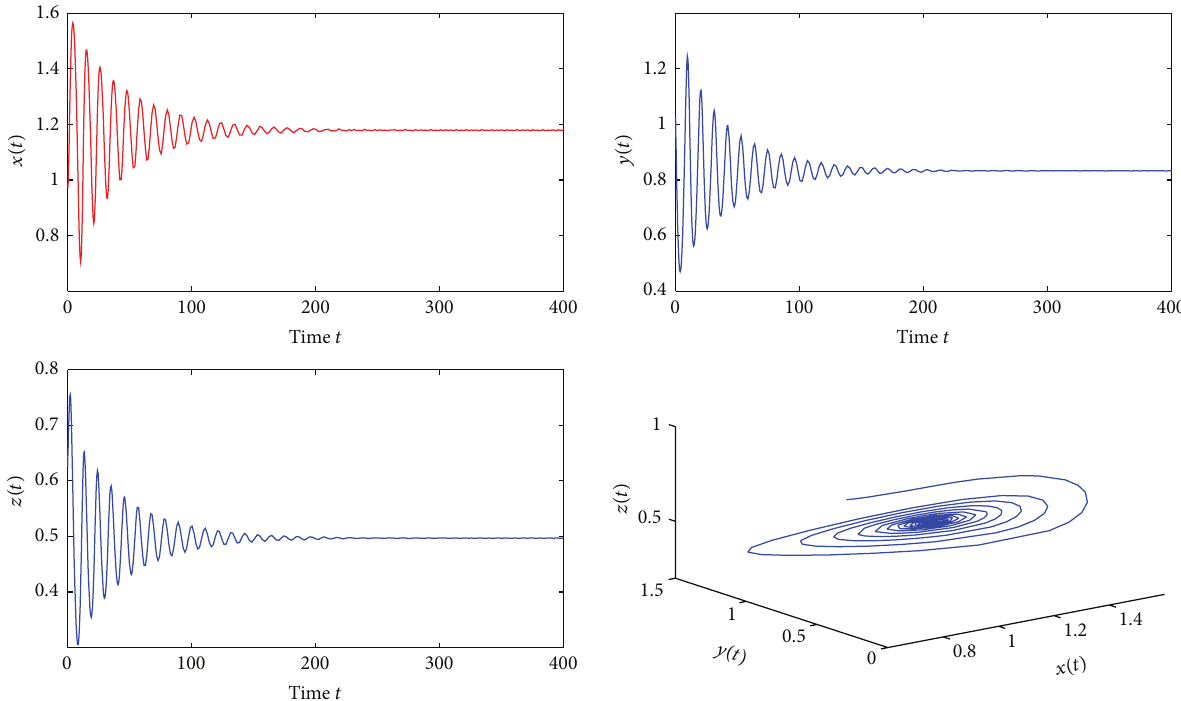
Figure 7: 𝐸 ∗ is asymptotically stable for 𝜏 2 = 1.25 < 𝜏 ∗ 2 = 1.4818 and 𝜏 1 = 0.5 with initial values 0.975, 1.025, and 0.625.